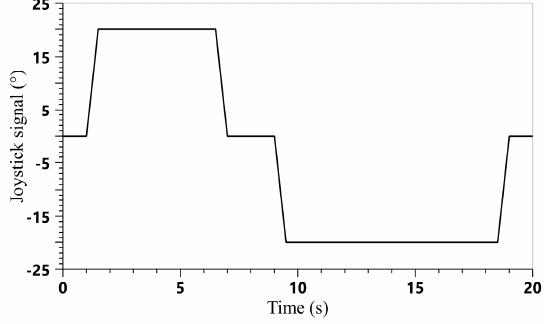
Figure 8. Cycle of the boom joystick.